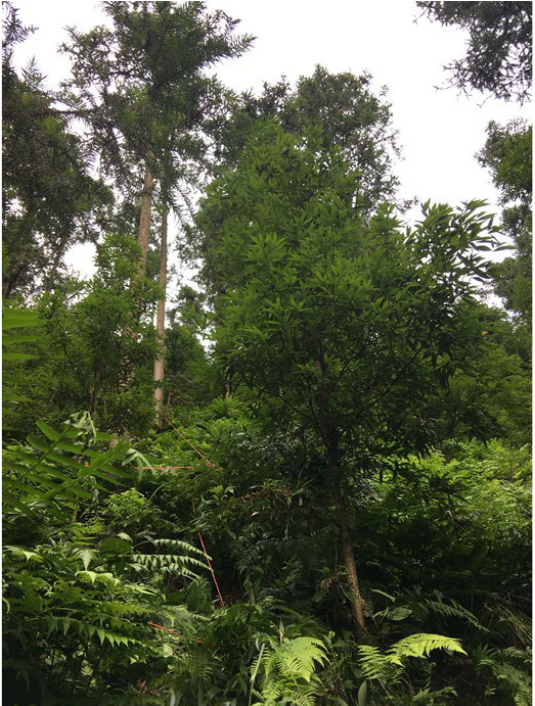
Figure 5. Our sample plots were replanted with Phoebe bournei in the understory of Cunninghamia lanceolata trees to create a mixed forest of CLPB , changing the stand structure to form a heterogeneous, complex, mixed forest.